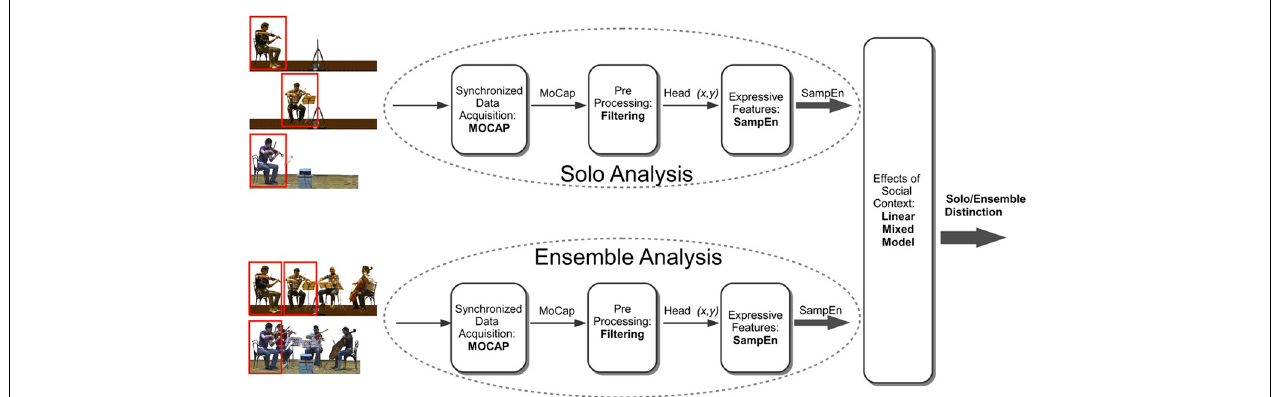
FIGURE 4 | Visualization of the data processing and analysis steps in evaluation of the difference between solo and ensemble performance. Research on complex patterns of behavior requires attention to data acquisition, preprocessing, extraction of expressive features, and analysis of the way expressive features vary with social